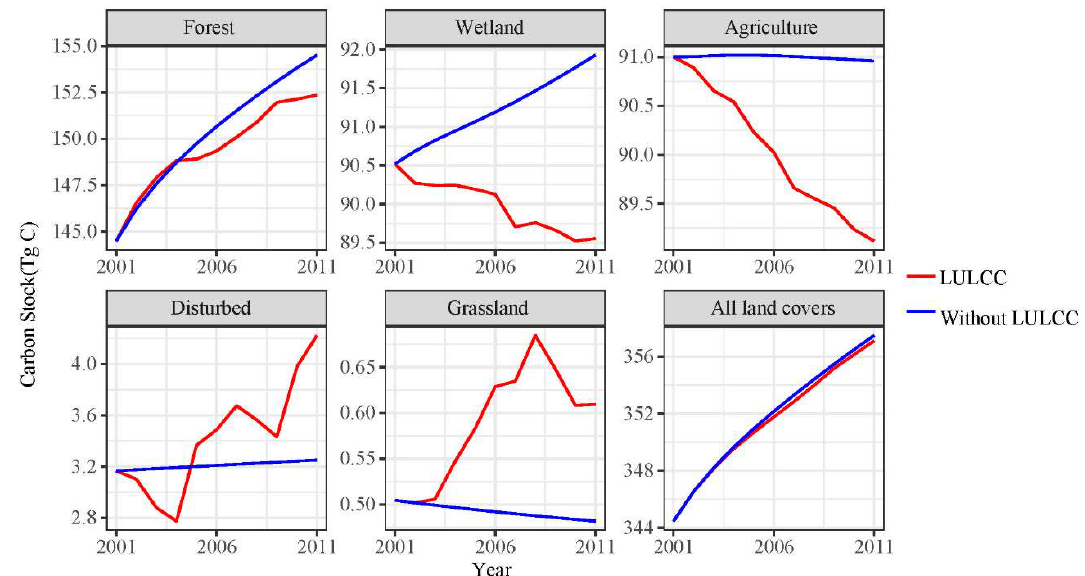
Figure 5. Carbon trends simulated under two land-cover change scenarios. Scenario LULCC entails simulating carbon stocks based on the annual LULCC data from LCMAP. Scenario without LULCC means simulating carbon stock based on land covers in 2001 from LCMAP. LULCC; land-use and land-cover change.